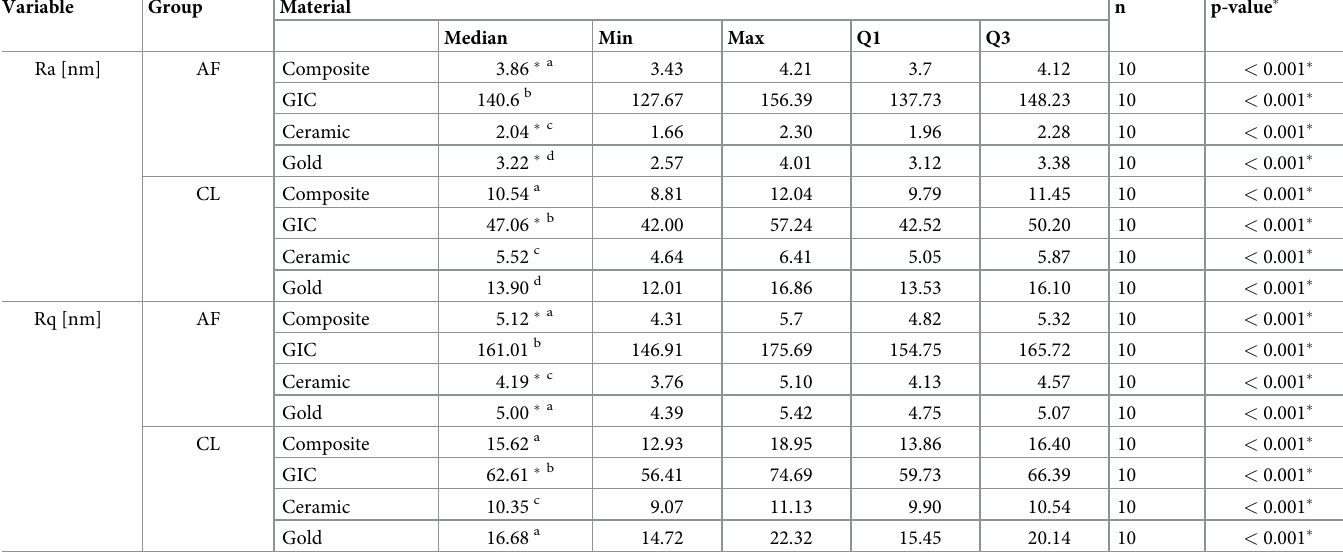
Table 5. Median, maximum, minimum, first and third percentile for Ra and Rq of the different materials in nanometres. Roughness of materials increases after treat- ment with AF and CL. Variable